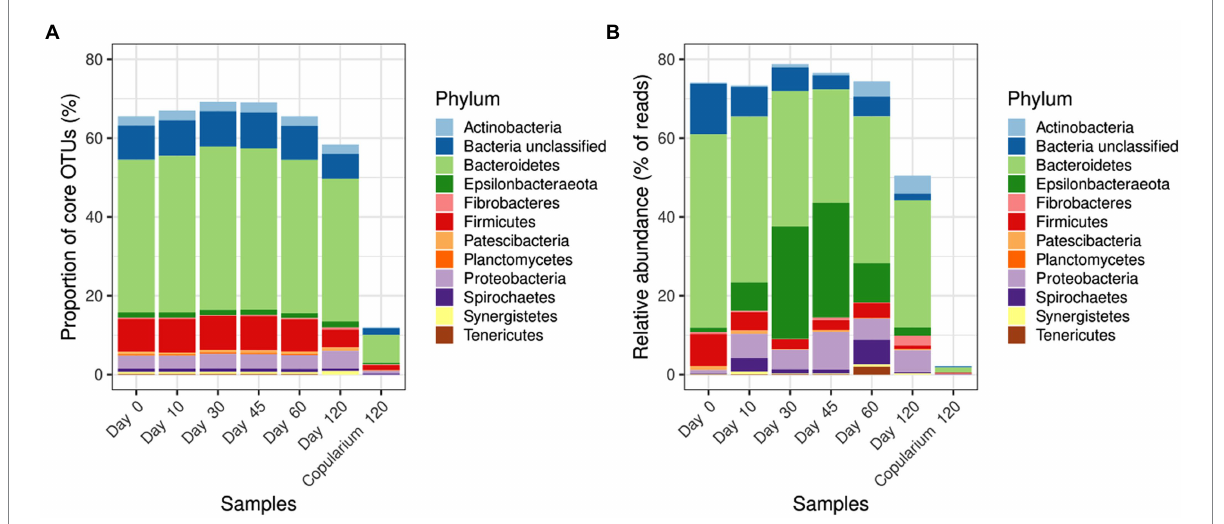
FIGURE 7 Taxonomic distribution of core bacterial OTUs in libraries from the gut of M. susbhyalinus reproductives over the colony foundation period, in comparison with the copularium at day 120. The significance of core OTUs in libraries is expressed either as a percentage of the number of OTUs (A) or as a percentage of the number of reads (B)